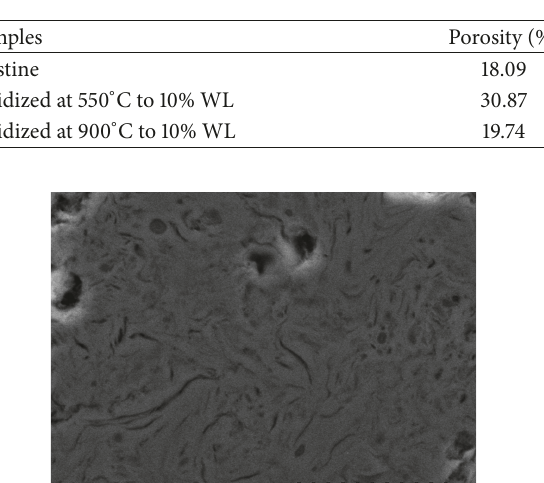
Table 3: Porosity of MG specimens (both pristine and oxidized) measured by Mercury Porosimetry.